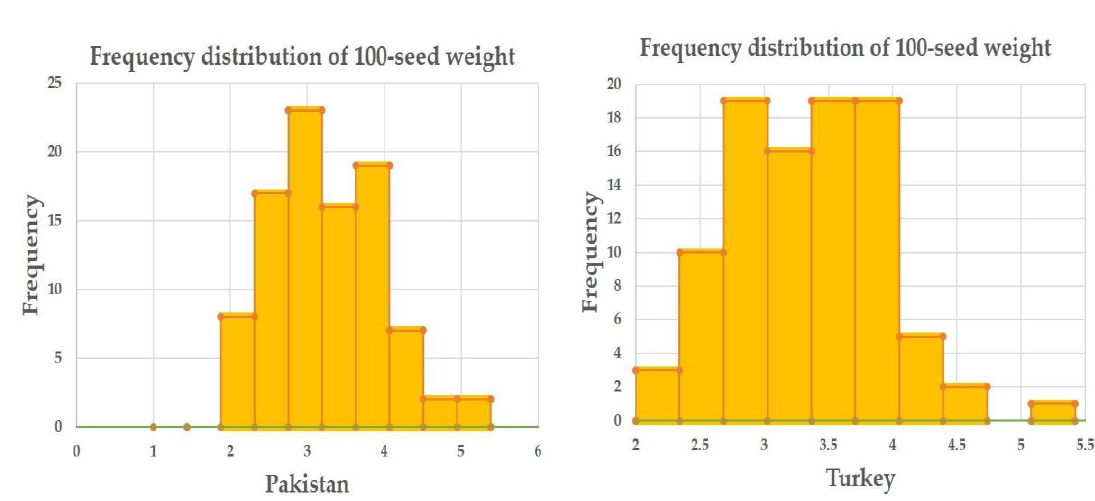
Figure 1. Frequency distribution chart for 100-seed weight for both studied locations (Pakistan and Turkey).